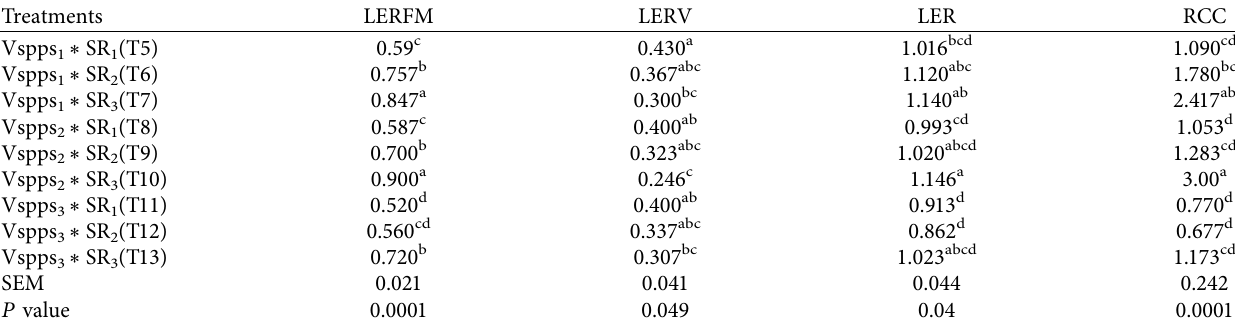
Table 5: Land equivalent ratio and relative crowding coefficient as affected by intercropping of finger millet and vetch species.